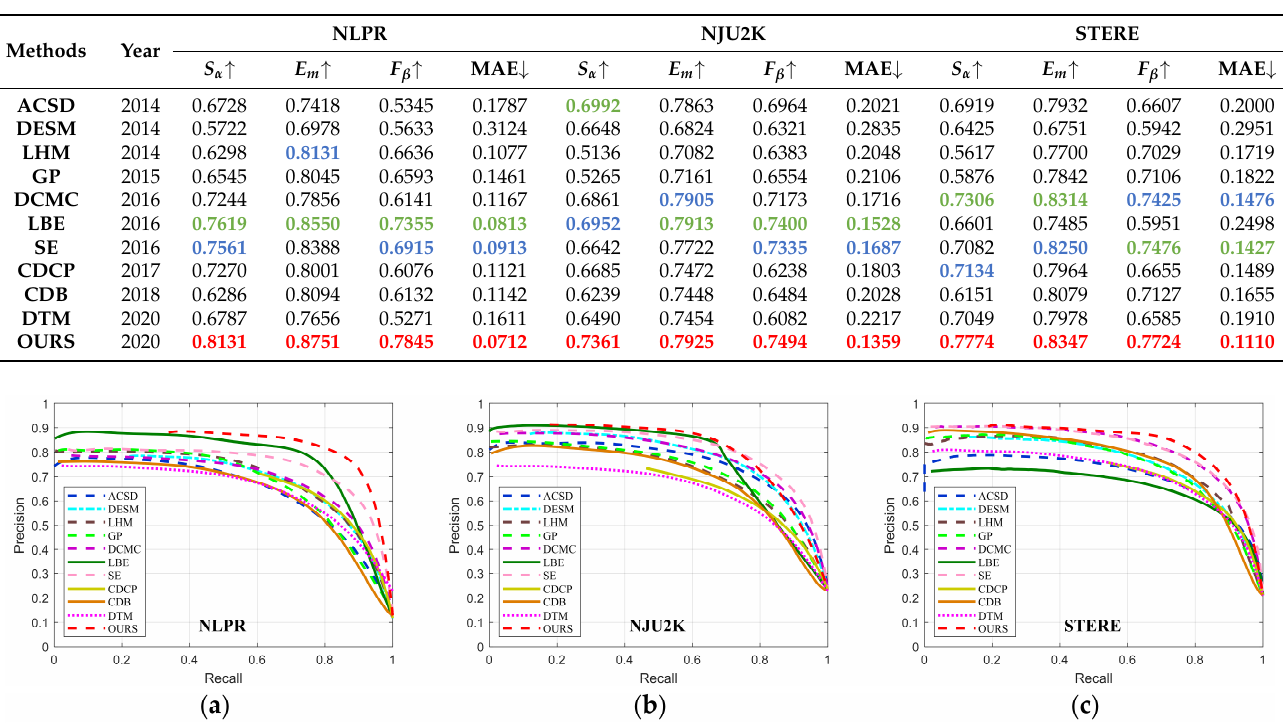
Figure 10. PR curves of the proposed and 10 state-of-the-art methods on 3 datasets. ( a ) NLPR dataset; ( b ) NJU2K dataset; ( c ) STERE dataset. Table 1. Quantitative comparisons of different RGB-D saliency detection methods on three popular datasets. Red , green and blue indicate the best, second and third performances. denotes larger is better, and denotes smaller is better. Methods